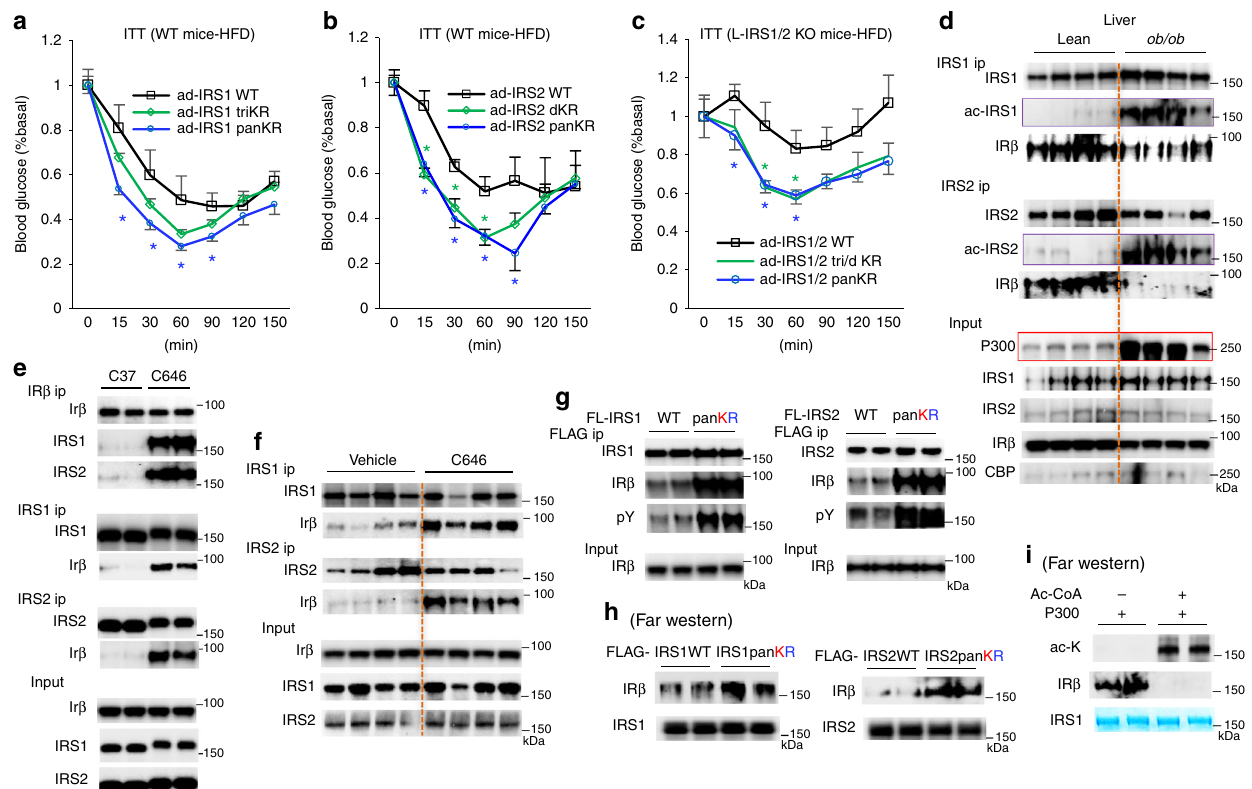
Fig. 8 Acetylation of IRS1/2 by P300 decreases their binding to IR β . a , b After injection of adenoviral IRS1 and its mutants a or adenoviral IRS2 and its mutants b , mice were fed an HFD for 2 weeks, then insulin tolerance tests (6 h fasting, 0.5 unit per kg) were conducted ( n = 5). *, P < 0.05, one-way analysis of variance test. c After injection of adenoviral IRS1/2-WT, adenoviral IRS1-triKR/IRS2-dKR, or adenoviral IRS1/2 panKR together with AAV8-TBG- Cre, mice were fed an HFD for 16 days, then insulin tolerance tests (6 h fasting, 0.5 unit per kg) were conducted ( n = 5). d Liver tissues were collected from 4-month-old heterozygous ( ± ) lean control and ob/ob mice. Immunoprecipitates were immunoblotted with IRS1/2, IR β , and anti-acetylated lysine antibodies. e Hepa1-6 cells were treated with 20 µ M C37 or inhibitor C646 for 4 h. f Liver tissues from HFD-fed mice were collected after 16 days of treatment with vehicle or inhibitor C646. g Forty-eight hours after the transfection of IRS1-WT, IRS1-panKR, IRS2-WT and IRS2-panKR expression plasmids, anti-FLAG magnetic meads were used to pull down these proteins. h Same amounts of IRS1-WT, IRS1-panKR or IRS2-WT, IRS2-panKR were employed in a SDS – polyacrylamide gel electrophoresis gel, and transferred onto a membrane, after renaturation, membranes were incubated with IR β , followed by incubation with anti-IR β antibody. i 36 h after the addition of adenoviral IRS1-WT to overexpress the IRS1 protein, Hepa1-6 cells were treated with inhibitor C646 for 16 h before harvest of cells to block IRS1 acetylation, and this protein was used in the Far-western blot. d , f Each lane represents a mouse sample. Data are presented as mean ±